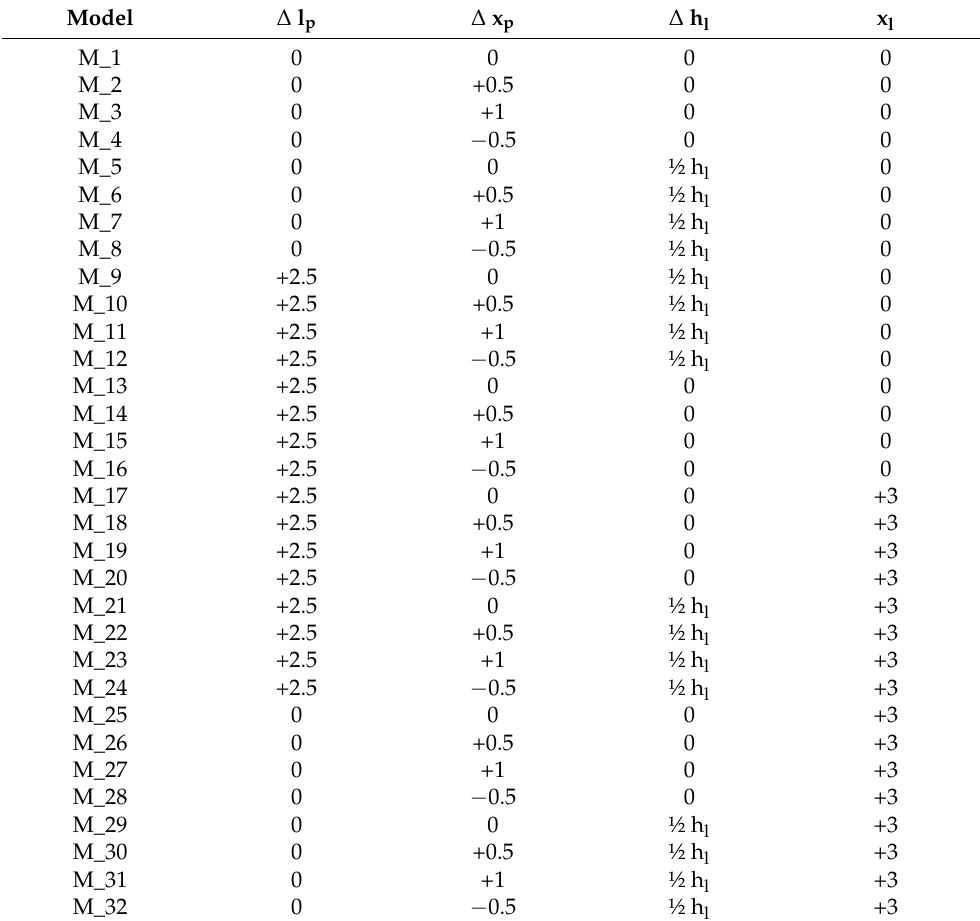
Table 4. Parameters of the tested auxiliary ventilation devices’ location